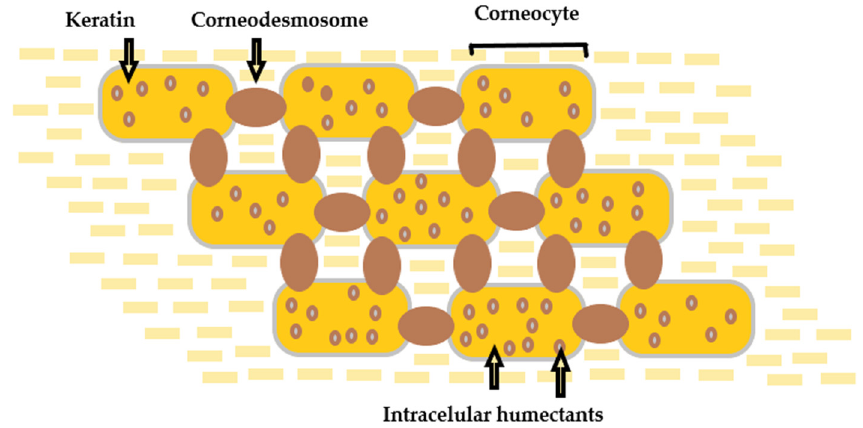
Figure 2. Structure of the stratum corneum —“brick and mortar” formation. The pathway between the stacked corneocytes is filled with “mortar” lipids.